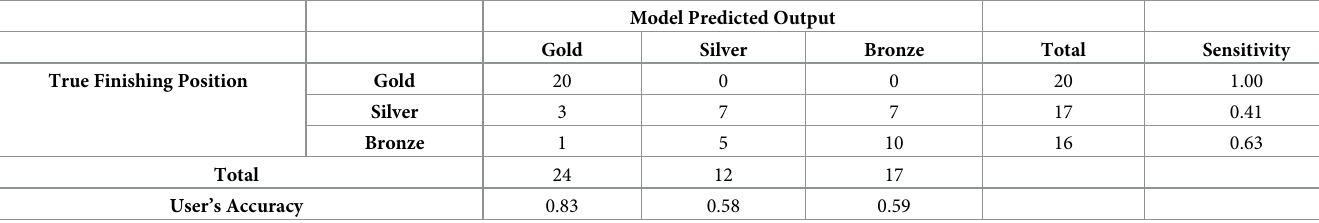
Table 3. RF2 misclassification matrix of medalling teams into three groups of Gold, Silver and Bronze.